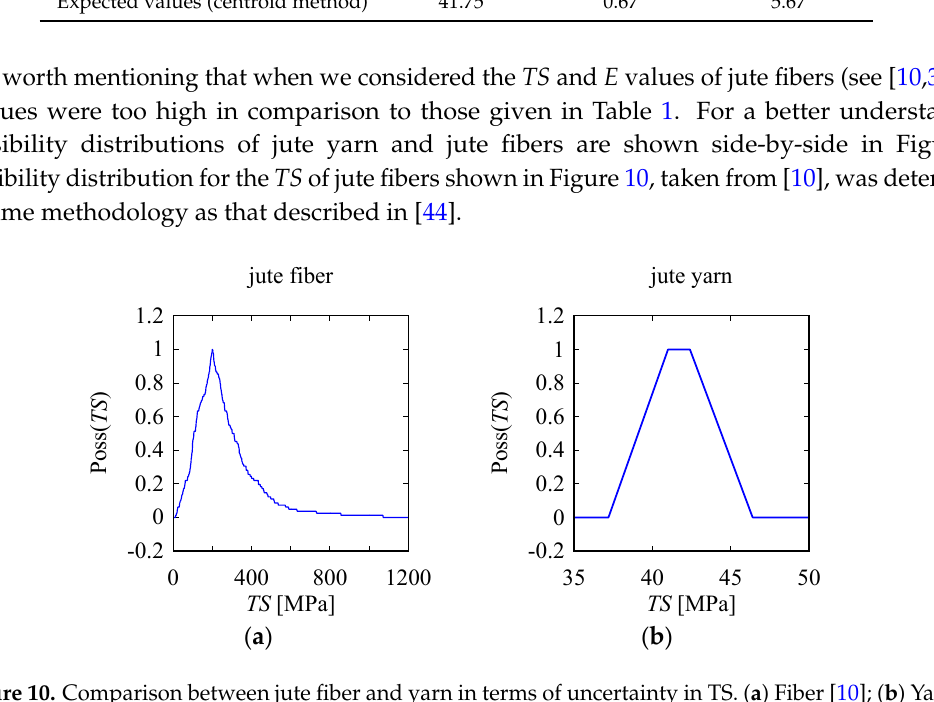
Figure 10. Comparison between jute fiber and yarn in terms of uncertainty in TS. ( a ) Fiber [10]; ( b ) Yarn (copied from Figure 9a).